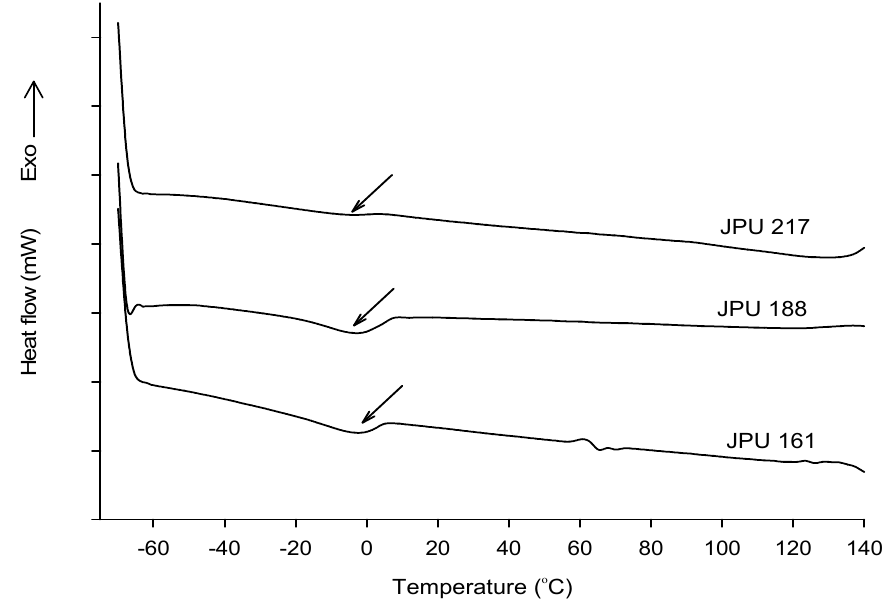
Figure 8. DSC thermograms of JPU films.